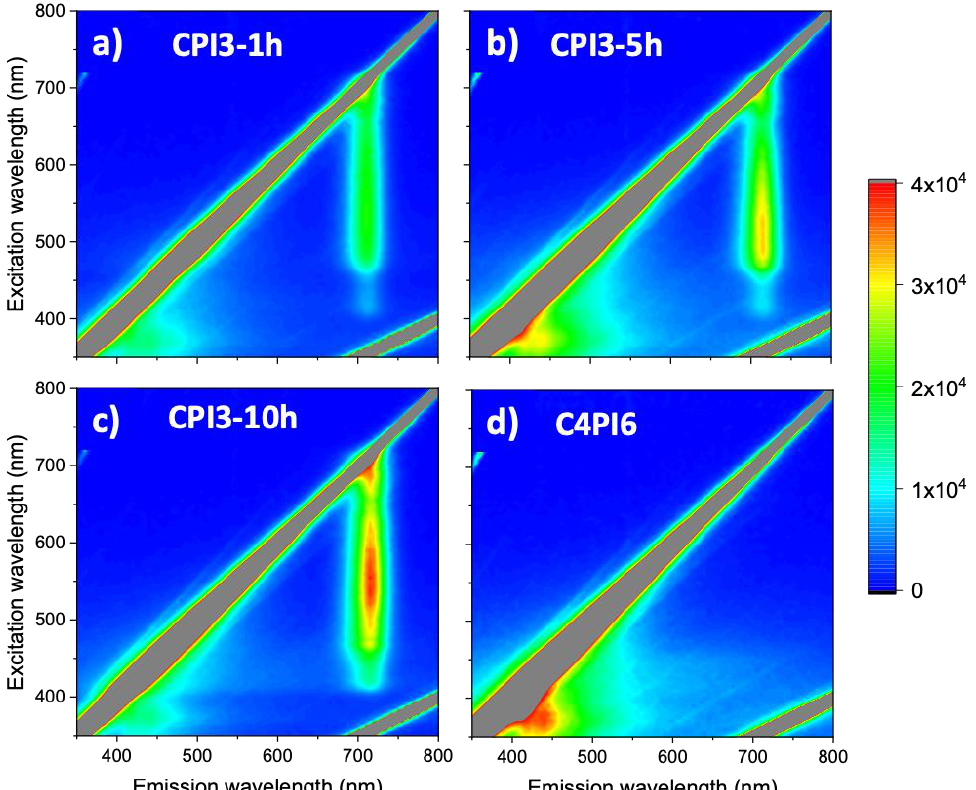
Figure 8. 3D-Photoluminescence excitation spectra of different samples: ( a ) CPI3-1 h, ( b ) CPI3-5 h, ( c ) CPI3-10 h and ( d ) C4PI6.